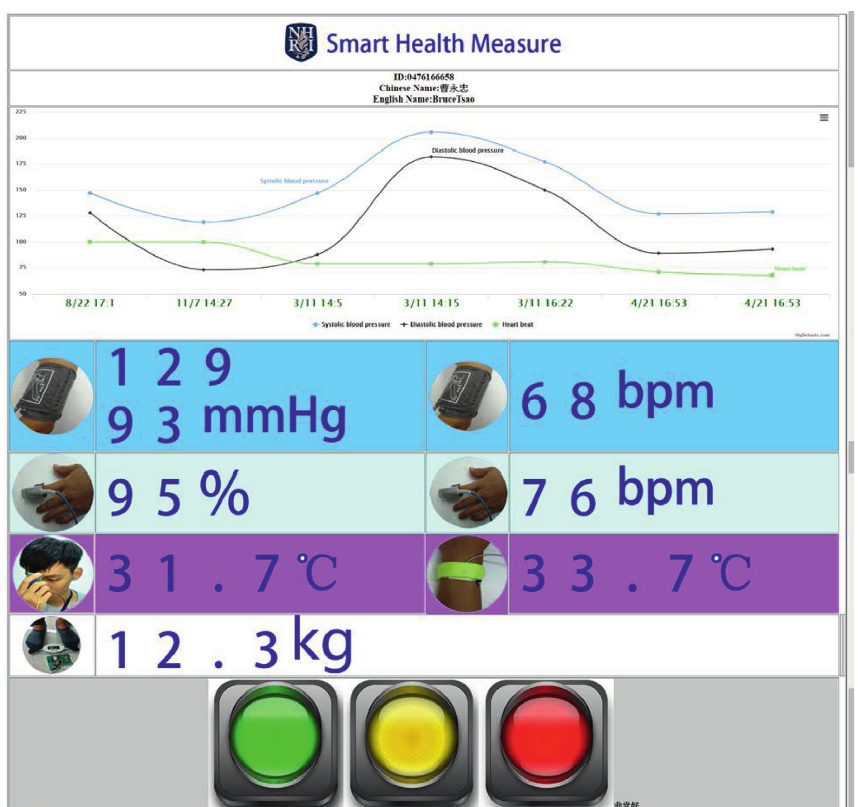
Figure 5: User profiles and physiological health parameters (essential vital signs) kept in the cloud platform developed in this paper. First, users access the website through a browser with their health ID card. The website generates visualized reports based on the measured data and displays a chart of data collected over the previous seven days to visualize the blood pressure trend. Other data can also be displayed side by side. User health is indicated by a red/yellow/green light indicator similar to a traffic signal for analysis and is then summarized from the user profiles and physiological health parameters. Users can also click on icons under the chart in Figure 5 to view the detailed data as a separate